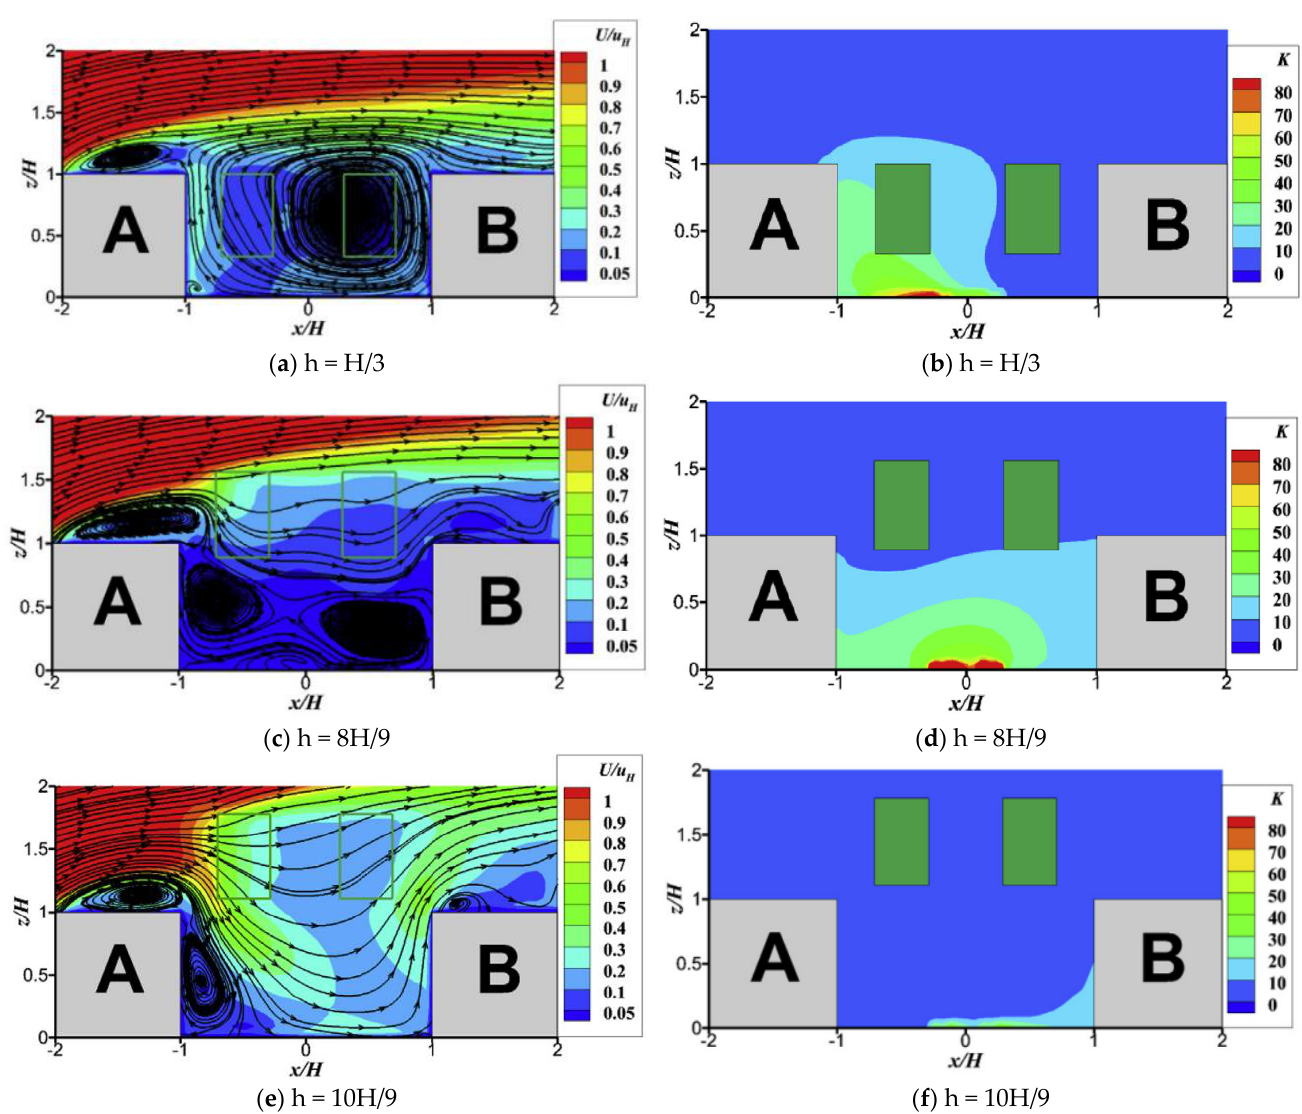
Figure 4. Normalized velocity magnitude contours and streamwise ( a , c , e ) and dimensionless pollutant concentration contours ( b , d , f ) on the vertical plane near the canyon center (y/H = 1.0) for the cases with DRTP under different trunk heights [11]. ( a ) h = H/3. ( b ) h = H/3. ( c ) h = 8H/9. ( d ) h = 8H/9. ( e ) h = 10H/9. ( f ) h = 10H/9.